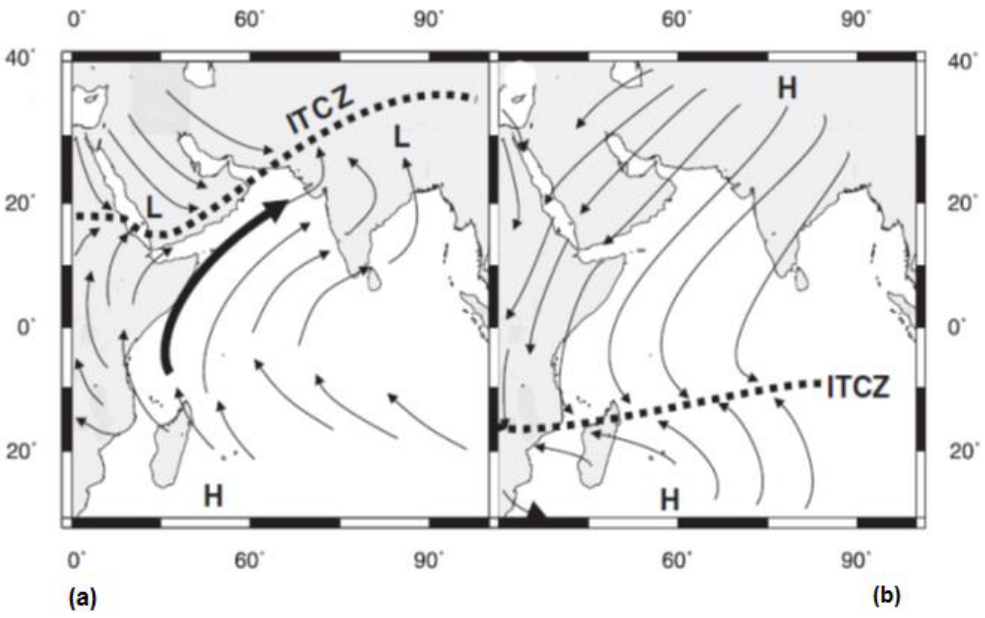
Figure 29. (a) Boreal summer (Indian Summer Monsoon season) and ( b ) boreal winter (northeast monsoon season). Bold dashed line marks the location of the ITCZ. Bold arrow marks the location of the Findlater Jet is also known as Somali Jet